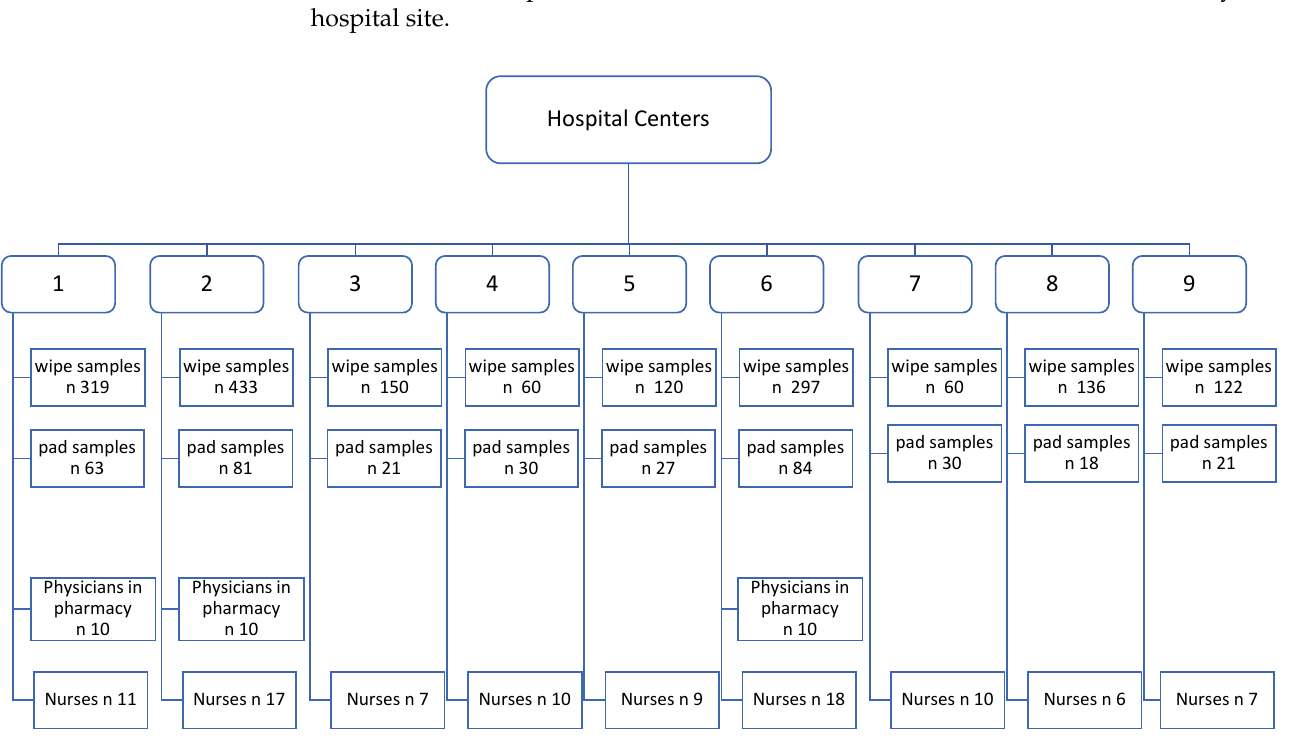
Figure 1. Schematic presentation of the study